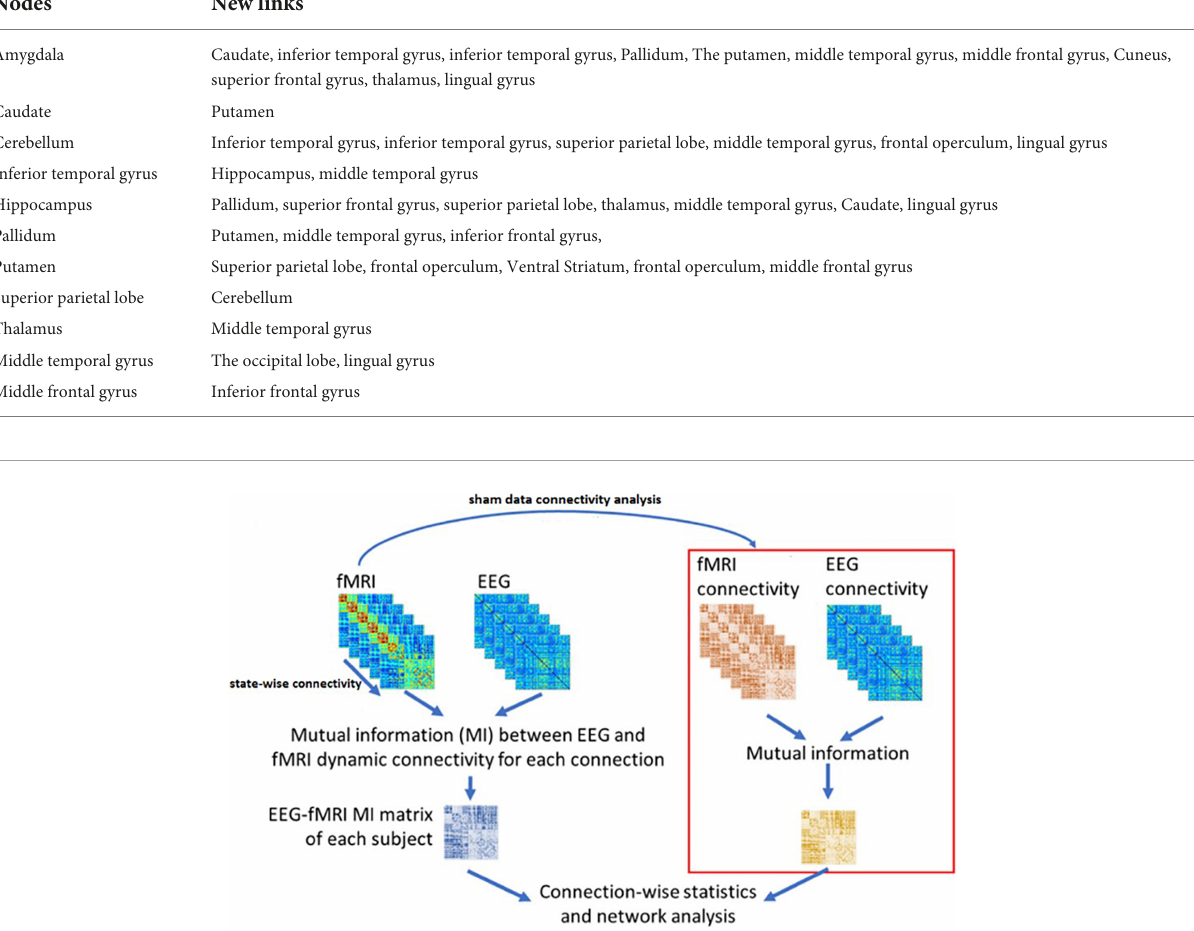
FIGURE5 The NMI analysis for EEG and fMRI dynamic Functional Connectivity matrixes. The sham group is used to determine the statistically significant link generated as the result of neurofeedback. The figure is obtained from Wirsich et al. (2020) with a few changes.